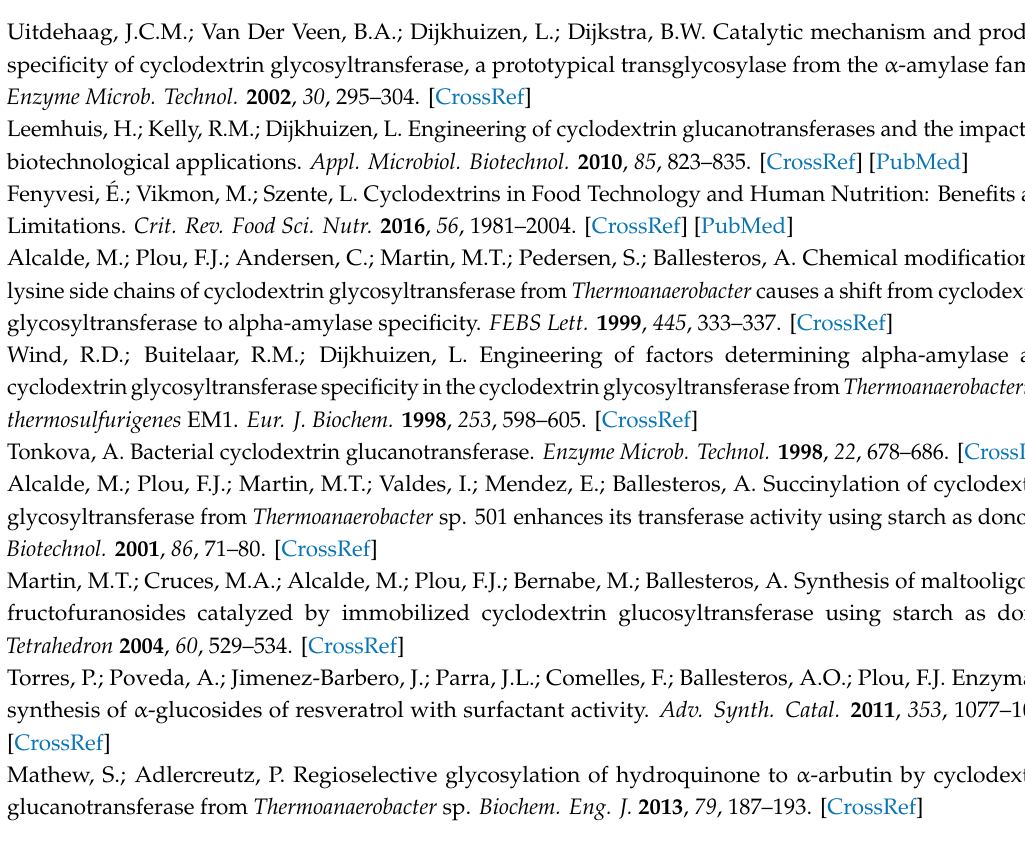
Figure S1: ESI-TOF spectrum (positive mode) of tert -butyl-O- α - d -glucopyranoside, Figure S2: ESI-TOF spectrum (positive mode) of tert -butyl-O- α